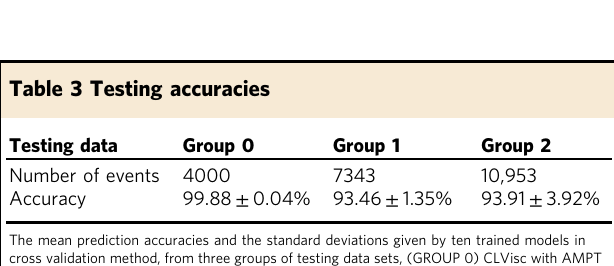
Table 1 we list the details of the training data set.